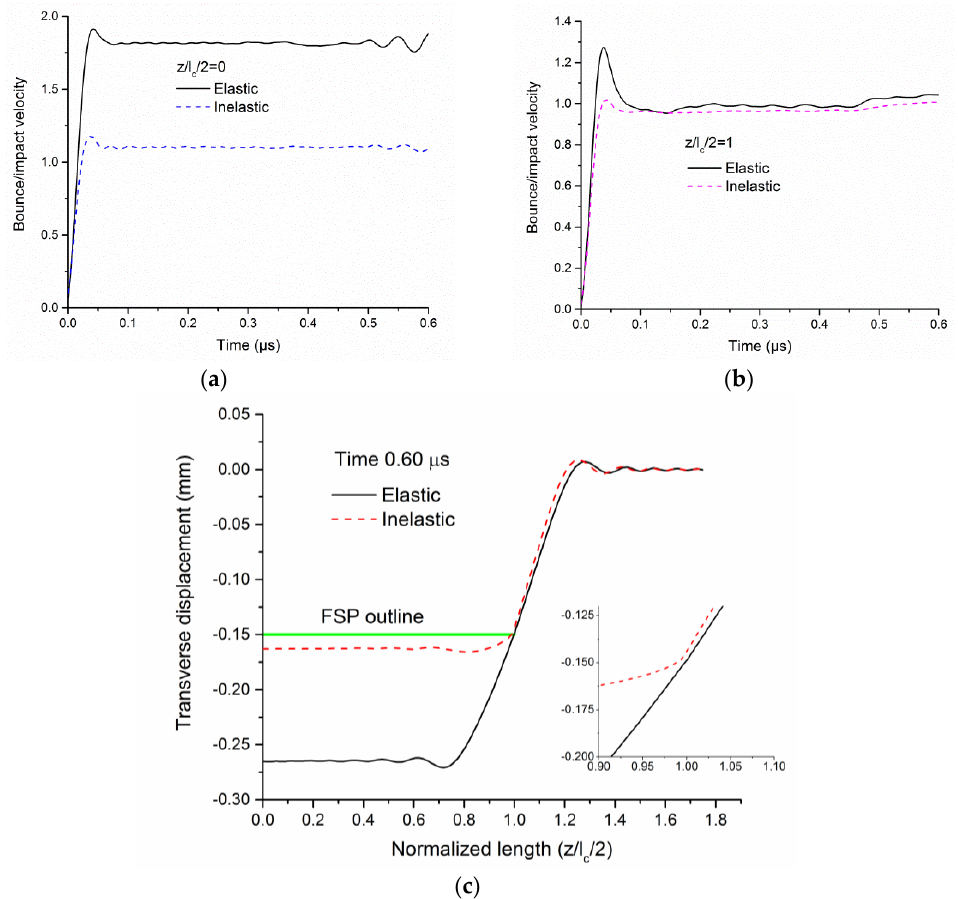
Figure 7. FSP impact at 250 m/s: ( a ) bounce/impact velocity at z/lc/2 = 0; ( b ) bounce/impact velocity at z/lc/2 = 1; and ( c ) transverse displacement at 0.60 µs.